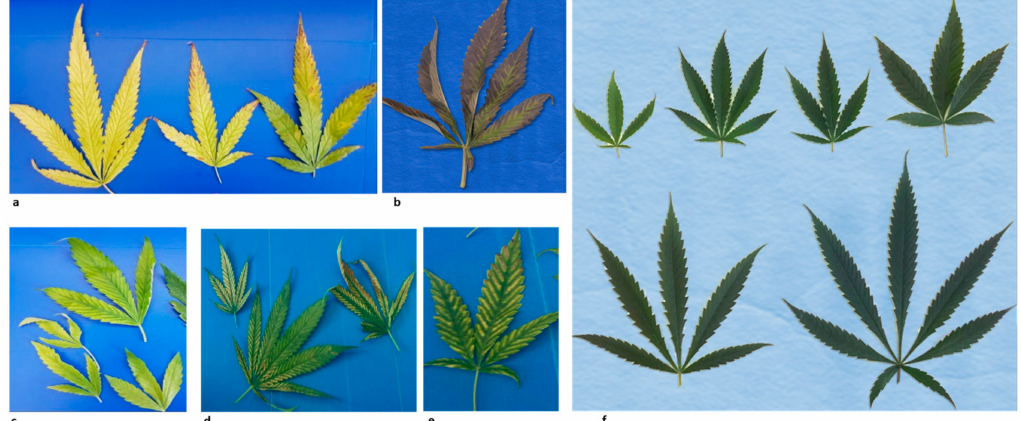
Figure 1. Disease symptoms of lettuce chlorosis virus on old leaves of cannabis plants at the vegetative stage. ( a ) Yellowing leaves showing necrosis. ( b ) Purple leaves. ( c ) Chlorotic leaves. ( d ) Interveinal yellowing leaves showing necrosis, ( e ) Interveinal yellowing leaves. ( f ) Cannabis leaves of uninfected ‘healthy’